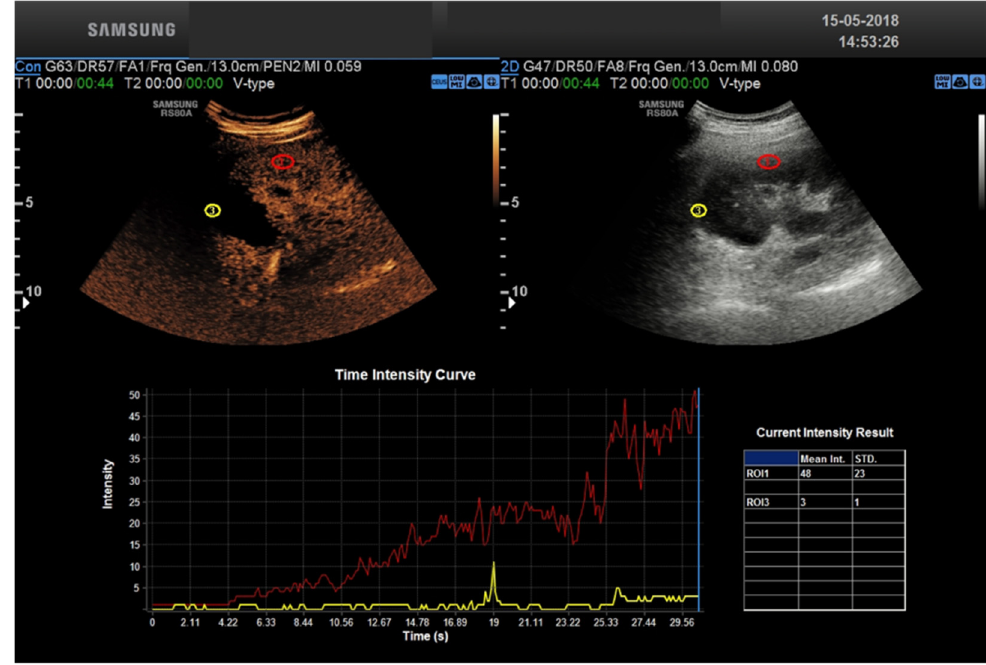
Figure 3. Ischemic Kidney TIC.